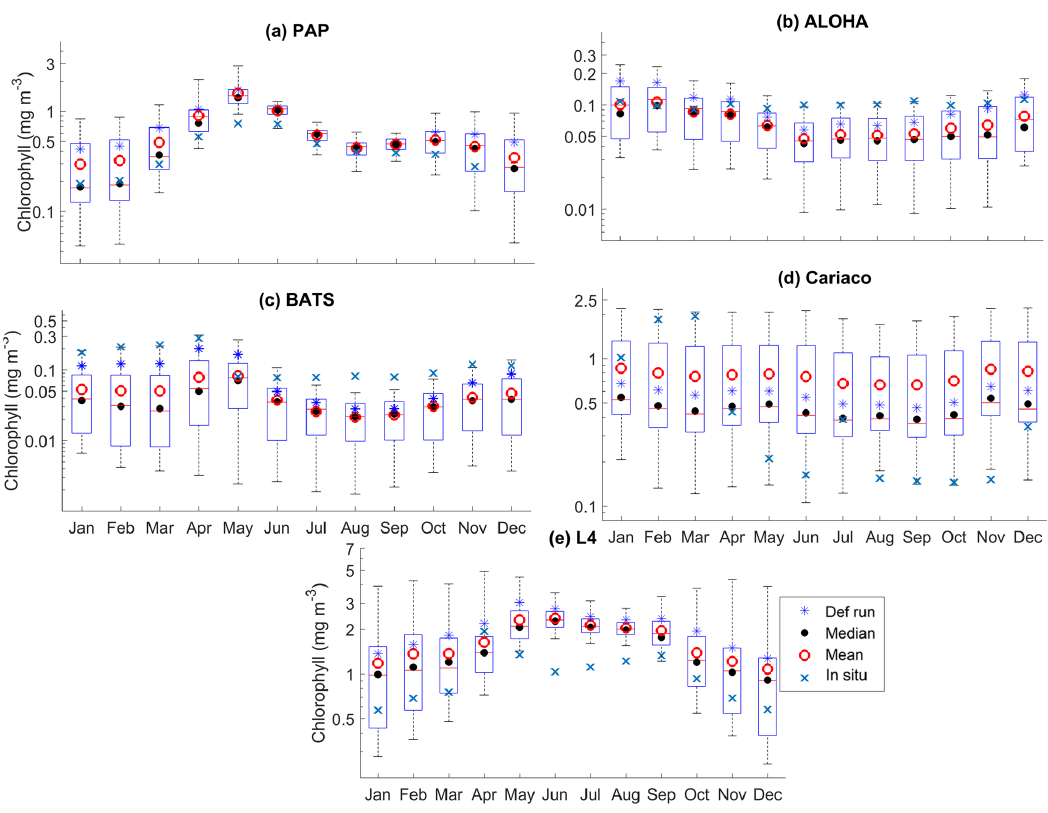
Figure 5. The 10-year monthly mean surface chlorophyll from all the study sites ( a–e ), showing the seasonal dynamics of surface chlorophyll (mgm − 3 ). The box plots show the ensemble seasonal means. The blue cross is the in situ observation; the red open circle, black dot, and blue stars are the ensemble mean, median, and the default run respectively. The blue box is the 75th and 25th quartiles. The red line is the median. The whiskers are the ensemble minimum and maximum mean of surface chlorophyll. In station PAP, in situ data for December are not available due to low light and high cloud